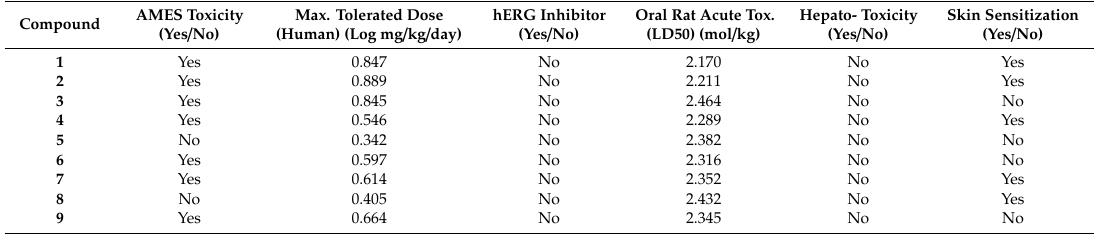
Table 7. Toxicity data for 3,4-dmethoxy- β -nitrostyrene derivatives (acquired using pkCSM online tool).